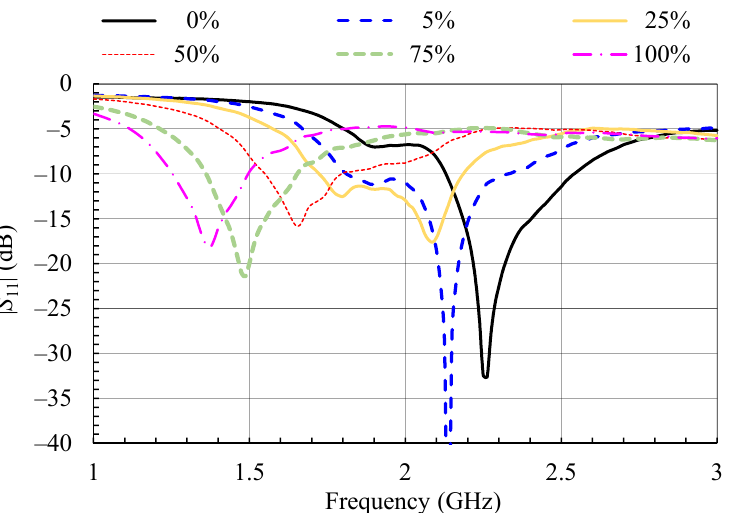
Figure 5. Measured magnitude of the input reflection coefficient of the textile PIFA for different moisture contents [13,16].